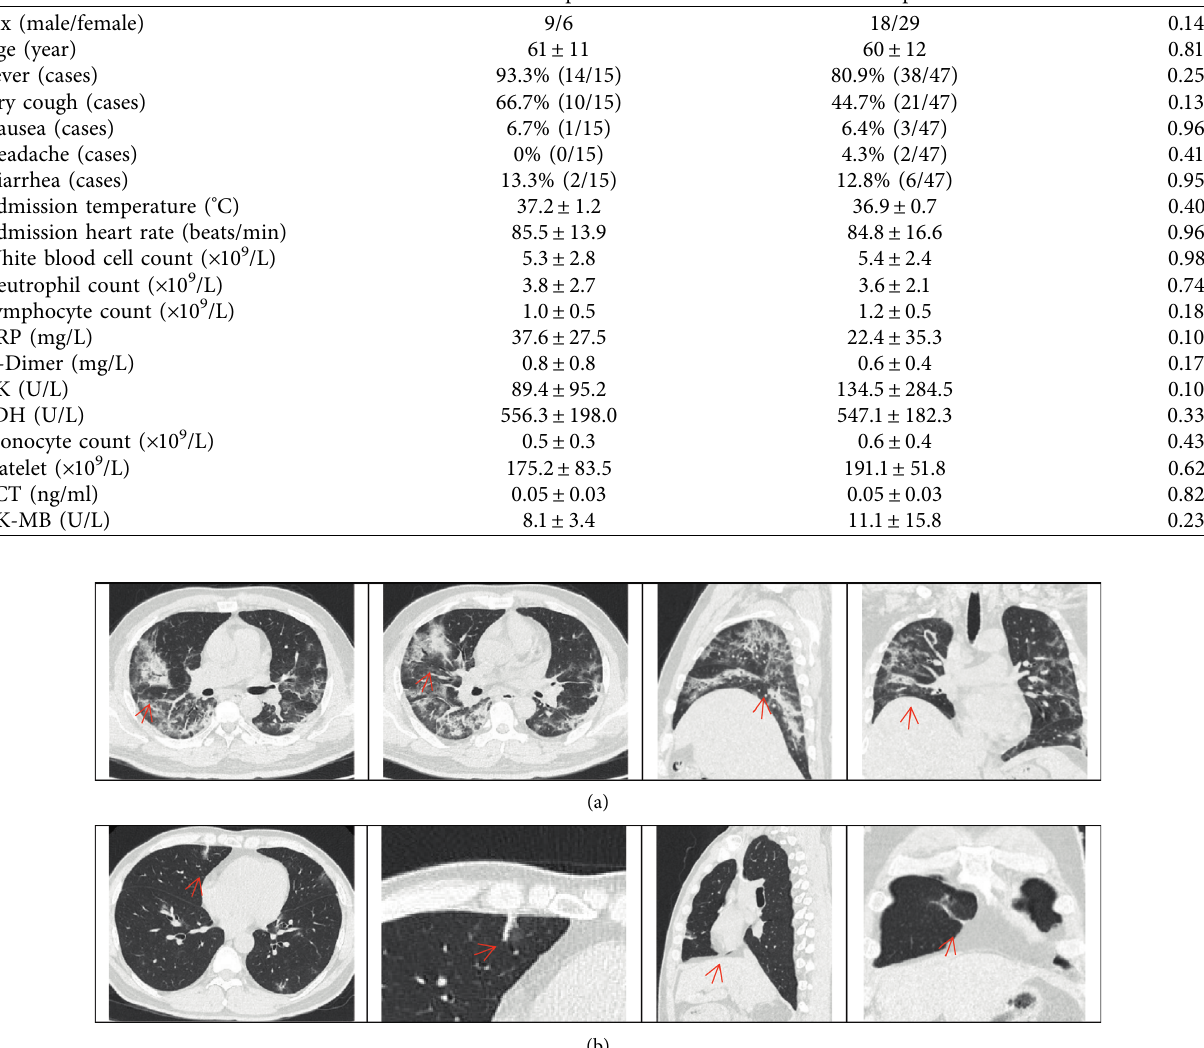
Figure 3: Chest CT findings in COVID-19 patients with T2DM and NDM. (a) Male, 49 years old, common type COVID-19, 10-year history of T2DM. Patchy shadows can be seen in multiple lobes of both lungs, local consolidation can be seen in the middle lobe of the right lung, and air bronchi signs can be seen inside. (b) Male, 41 years old, common type COVID-19, NDM. Patchy shadows are seen in multiple lobes of both lungs, with local consolidation in the middle lobe of the right lung.